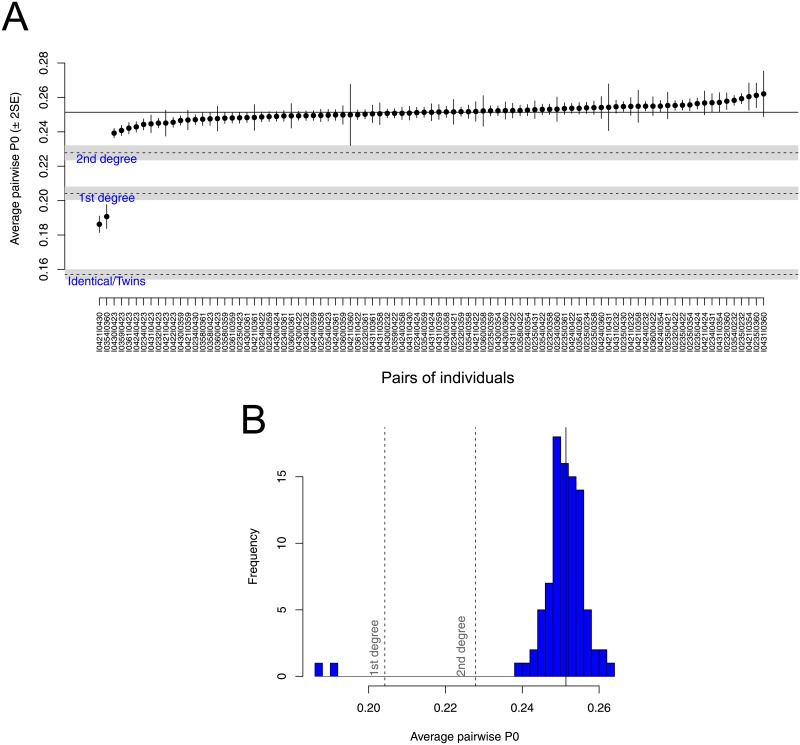
READ estimates for the Srubnaya sample.(A) Sorted non-normalized average P0 values for all pairwise comparisons between Srubnaya individuals. Error bars show two standard errors of the mean. The solid horizontal line indicates the median value used for normalization. Dashed lines show the cutoffs used to classify the related individuals. The gray areas around dashed lines indicate 95% confidence intervals for the cutoffs accounting for the uncertainty in estimating the average P0 in the pair used to set the baseline for unrelated individuals. (B) A histogram of the non-normalized average P0 values, vertical dashed and solid lines indicate the same as in (A). A similar plot is produced as output when running READ.